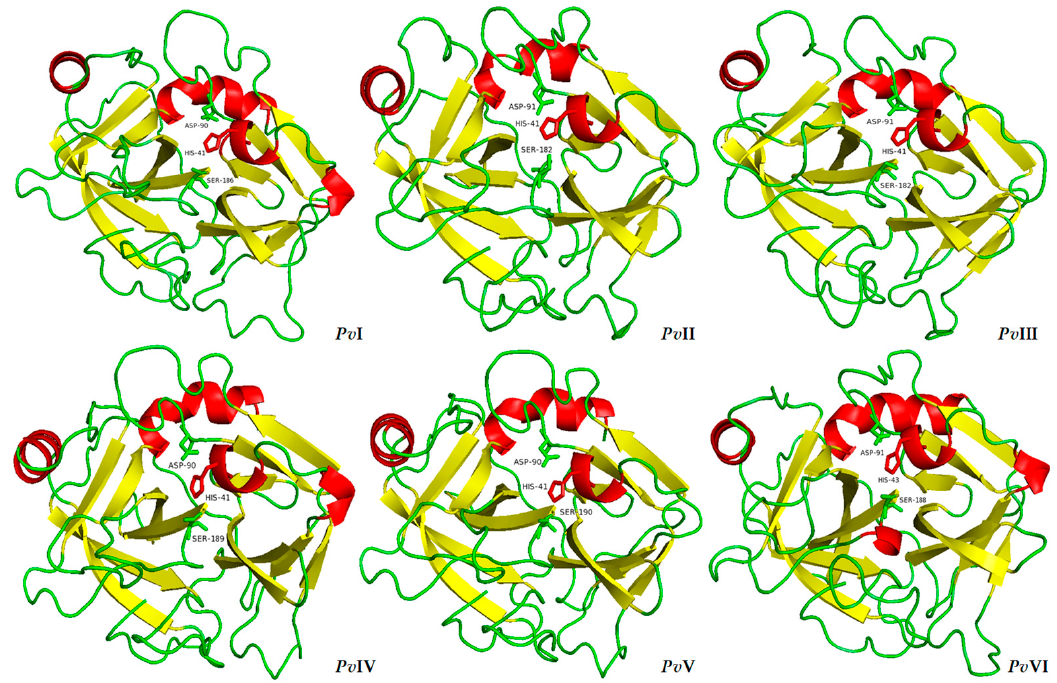
Figure 10. The 3D structures of Pv I– Pv VI. Each molecule consists of α -helix (red column), β -sheets (yellow arrows) and unordered regions (green thread) that form two super-secondary structure motifs and one cleft. Active site residues (Ser, His and Asp) are in the cleft as indicated in the figure.